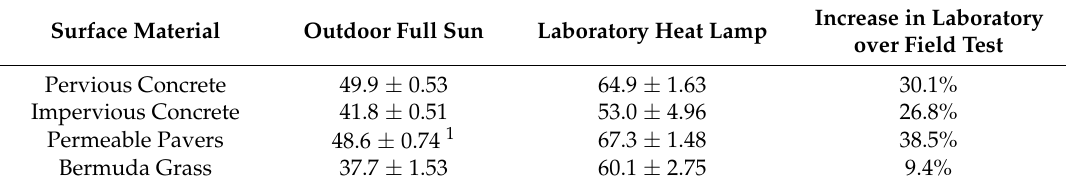
Table 3. Comparison of steady-state surface temperature data for selected materials, outdoor field lab vs. laboratory thermal input, ◦ C, Auburn,